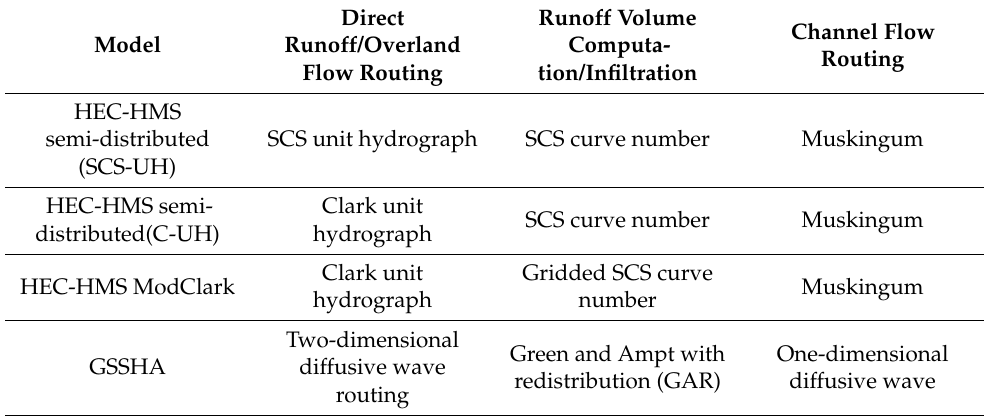
Figure 18. The gridded CN for the ModClark model. Table 4. Modeling approach.